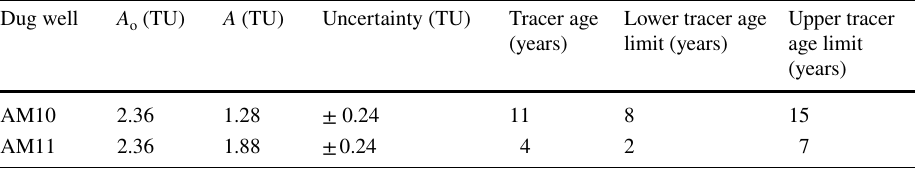
Table 4 Calculated tritium activities of young ground waters collected downstream of